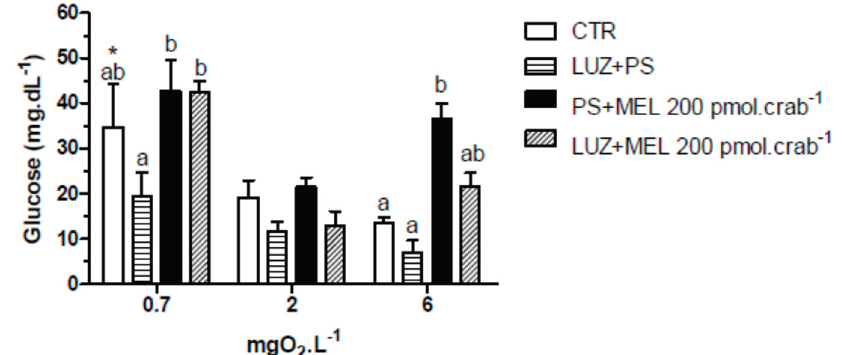
Again, injections of melatonin (200 pmol·crab − 1 ) significantly increased ( p < 0.05) glucose levels in intact crabs (Figure 8) exposed to 6 mgO 2 ·L − 1 (36.4 ± 3.5 mg·dL − 1 ); but crabs that were also injected with luzindole (200 nmol·crab − 1 ) did not differ ( p > 0.05) from the control group (21.5 ± 3.5 and 3.4 ± 1.3 mg·dL − 1 , respectively). No significant effects ( p > 0.05) of melatonin or luzindole were observed in crabs exposed to 2 mgO 2 ·L − 1 . In 0.7 mgO 2 ·L − 1 a general increase of glucose levels was observed in the treatment groups (34.7 ± 9.5 mg·dL − 1 , CTR as reference; p < 0.05 compared to CTR of 6 mgO 2 ·L − 1 ). Figure 8. Circulating glucose concentration in intact Neohelice granulata exposed for 45 min to three different dissolved-oxygen concentrations (0.7, 2 or 6 mgO 2 ·L − 1 ) and injected with physiological saline only (CTR), luzindole (200 nmol·crab − 1 ) plus physiological saline, physiological saline plus melatonin (200 pmol·crab − 1 ), or luzindole (200 nmol·crab − 1 ) plus melatonin (200 pmol·crab − 1 ). Each point represents the mean ± SE ( n = 4–6). Different letters represent significant differences ( p < 0.05) between the groups with the same dissolved oxygen concentration. * represents a significant difference ( p < 0.05) from the CTR group at 6 mgO 2 ·L − 1